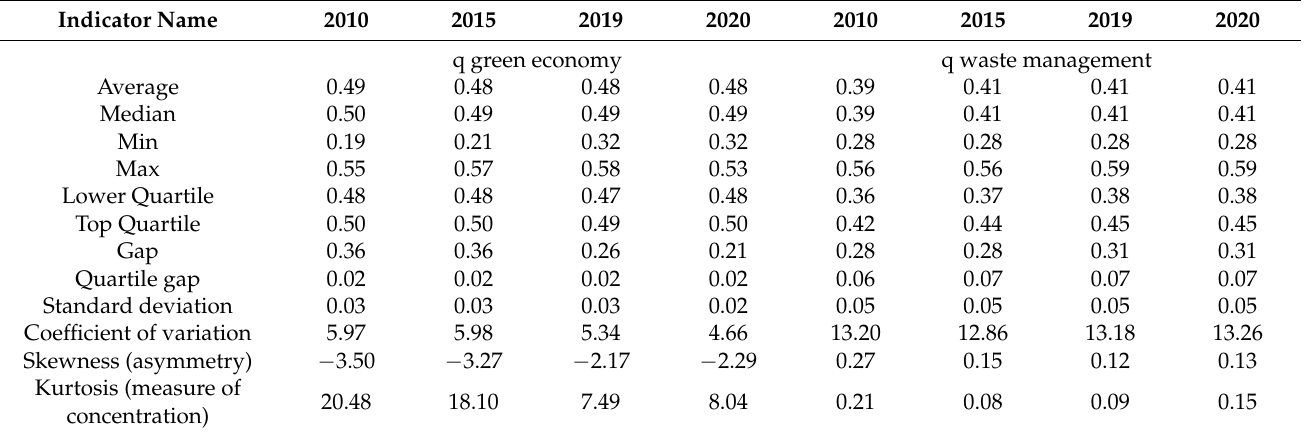
Table 2. Statistical characteristics of the synthetic measure, waste management and green economy in communes of Eastern Poland in 2010–2020.